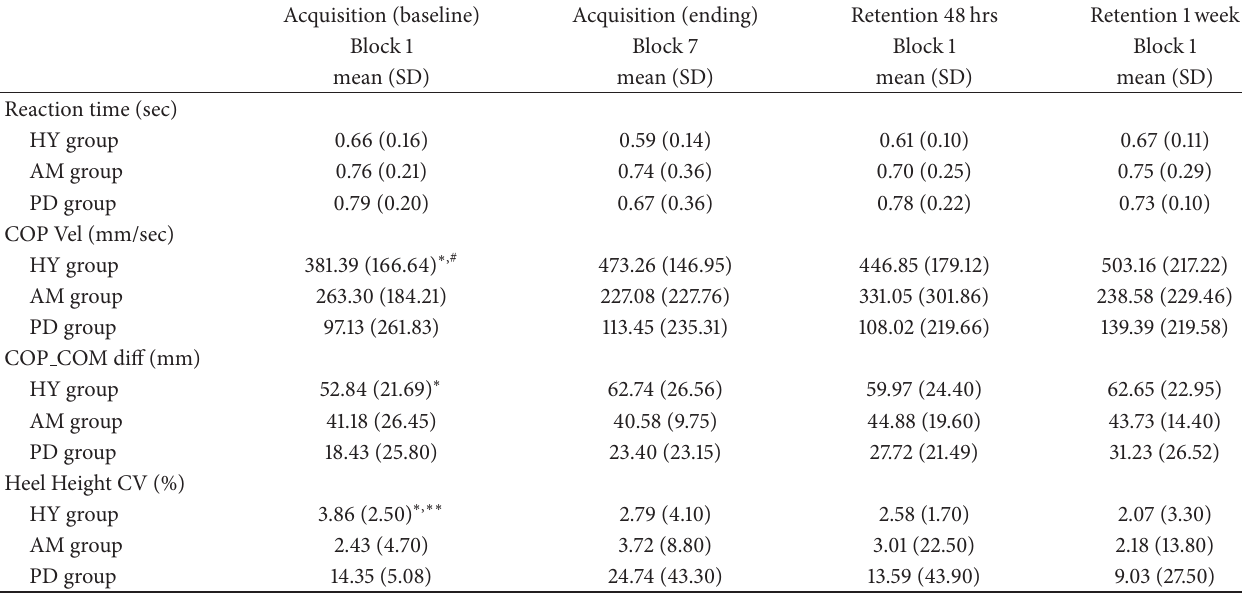
Table 2: Values (SD) for each postural control measure at acquisition and retention phases for each